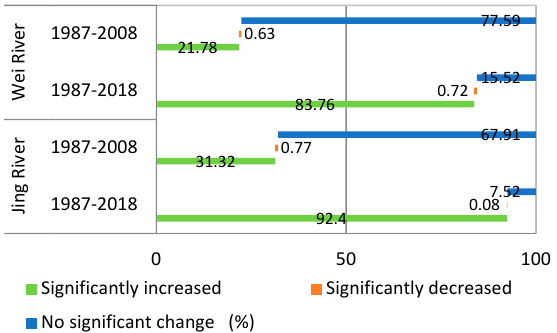
Figure 7. The proportion of NDVI significant change area in the Wei and Jing River Basin.